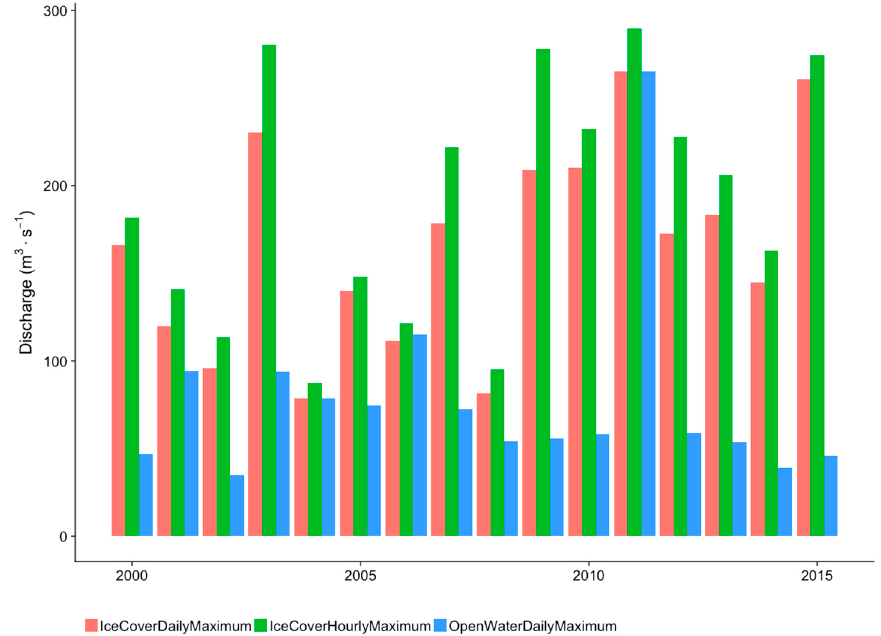
Figure 4. Comparison of winter 1-day maximum, computed for open water conditions (ice-corrected data with a daily time resolution, OpenWaterDailyMaximum), 1-day maximum from hourly raw data (IceCoverHourlyMaximum), and the 1-day maximum for daily raw data (IceCoverDailyMaximum). Note that for 2004, 2006, and 2011, the spring flood occurred in late March; therefore, the daily open water discharge with and without ice is similar and the hourly discharge represents the instantaneous hourly peak.